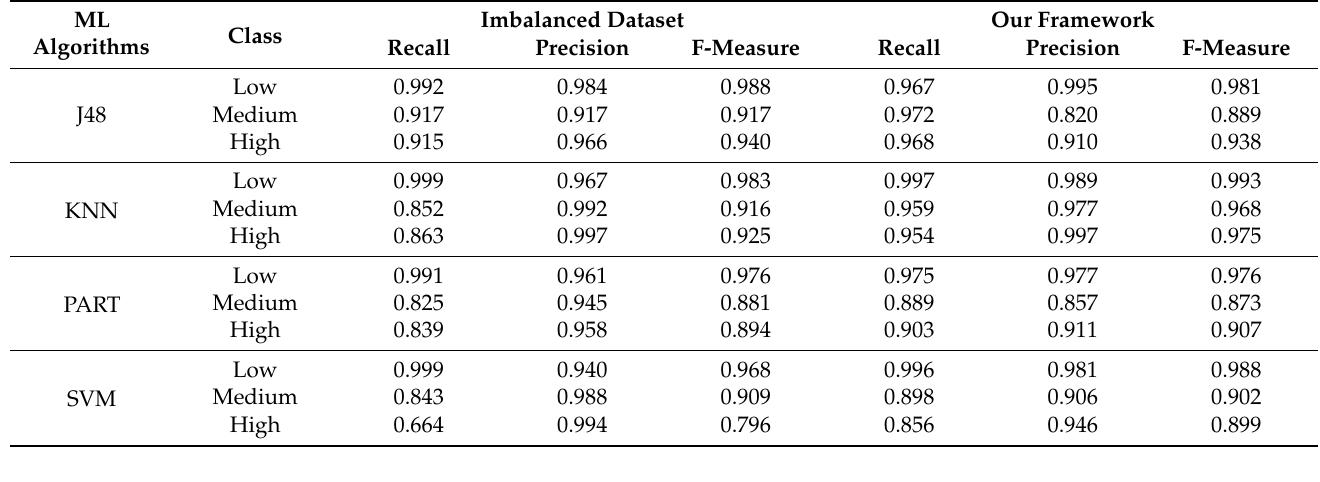
Table 4. Performance comparison between conventional methods and our framework in an imbalanced data environment.